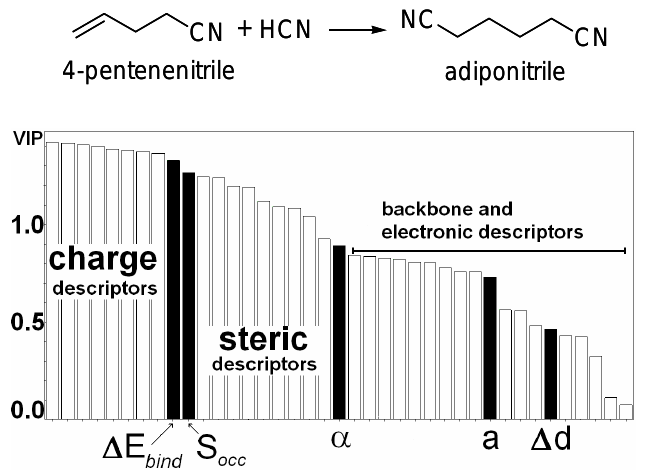
Figure 8 . Variable importance (VIP) plot, showing the importance of every descriptor in the model for the hydrocyanation of pentenenitrile. VIP values higher than 1.0 are attributed to descriptors that contribute most in the prediction of ligand activity. Charge descriptors refer to the Mulliken charge calculated at the ligating atoms. ∆ E is the energy difference between the free ligand and the metal bind complex, and can be related to the chelating effect and flexibility of the molecule. S is the sphere occ occupation descriptor and measures the sterics around the metal centre. α is the bite angle. a is the second derivative of the flexibility profile polynomial. ∆ d is the difference in the interatomic distance between the ligating atoms between the free ligand and the complex. Steric descriptors are calculated with the Steric® software. Backbone descriptors refer to properties calculated on the backbone